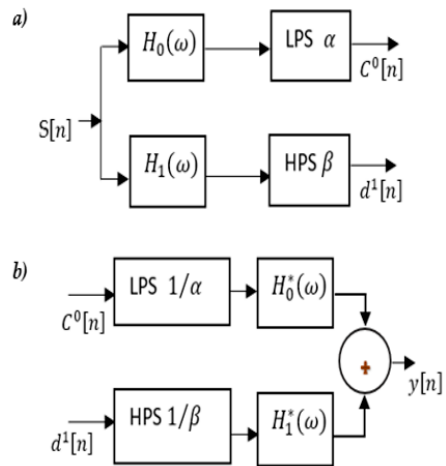
Figure 5. ( a ) Decomposition; ( b ) reconstruction, with stages of single-level tunable Q-factor wavelet